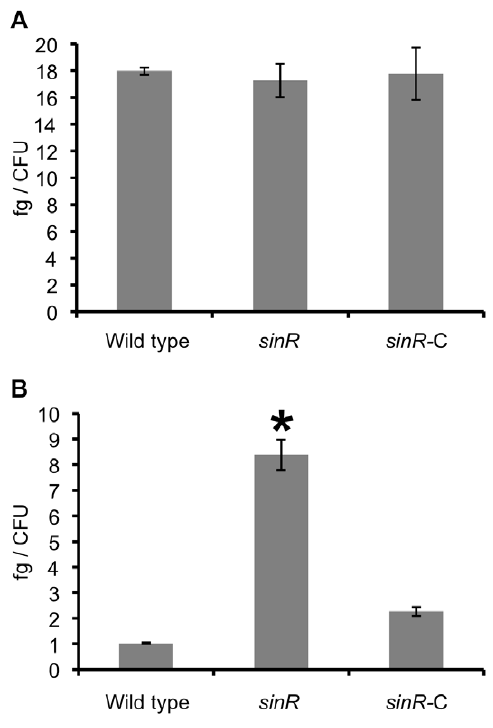
Figure 1. Quantification of components of biofilms formed by P.gingivalis strains. P. gingivalis strains were incubated in PBS for 24 h. After washing, the amounts of protein (A) and carbohydrate (B) per CFU were determined using the colorimetric methods described in the Methods section. Statistical analysis was performed using a Welch’s t test. * P , 0.001 in comparison with the wild type